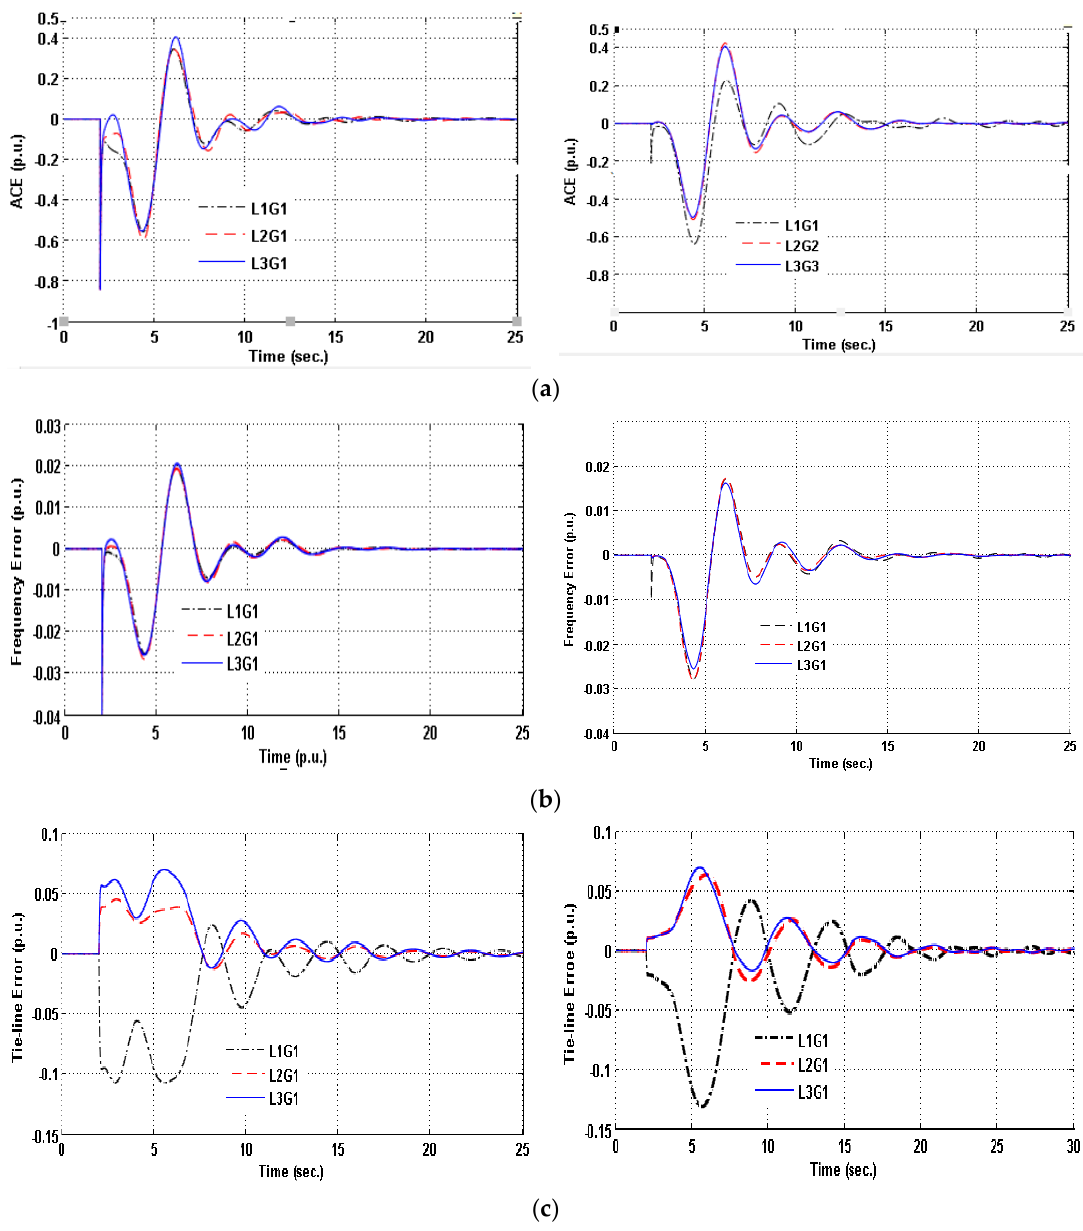
Figure 8. Effect of generator electrical proximity to the point of impact on generator G 1 before and after introducing new gain on: ( a ) ACE, ( b ) frequency error, and ( c ) tie-line error.